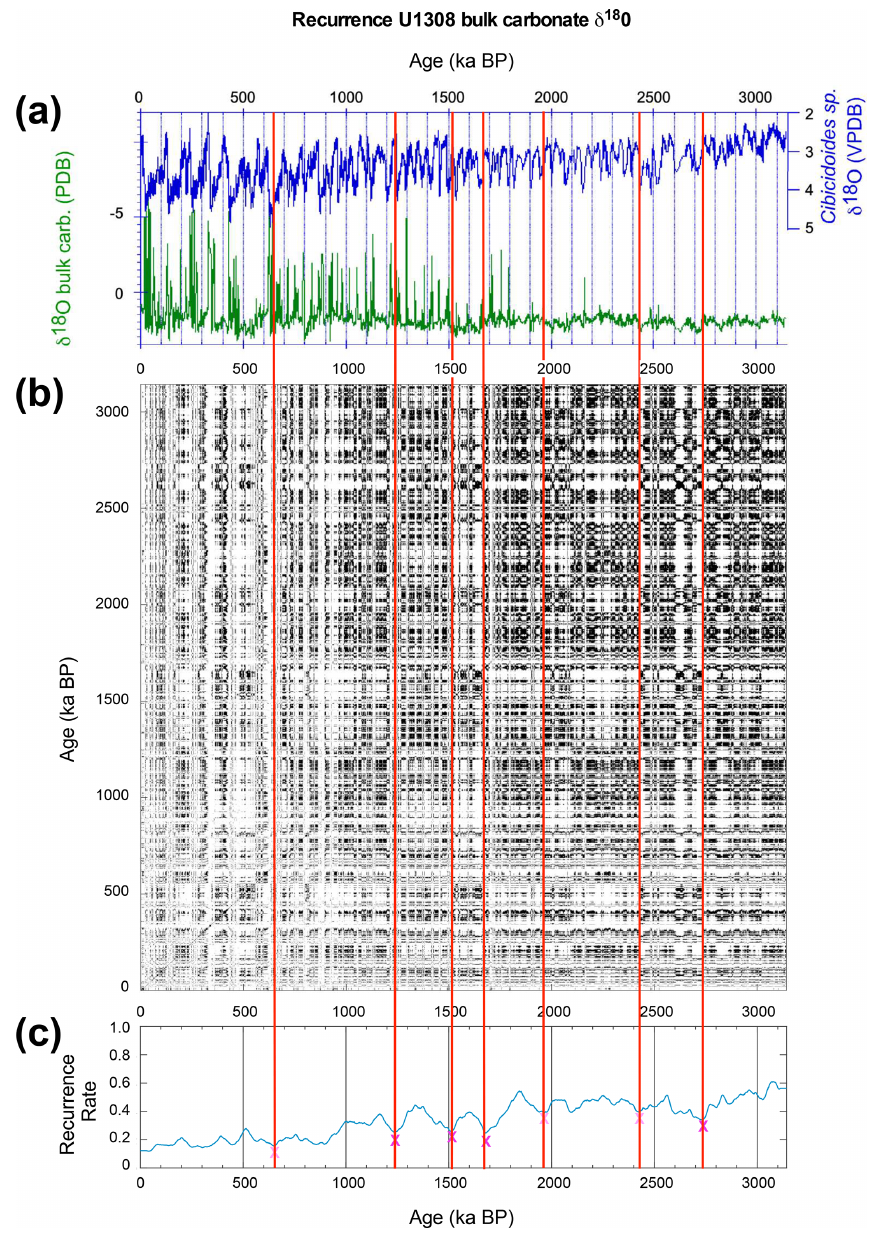
Figure 3. Recurrence analysis of U1308 bulk carbonate δ 18 O (Hodell and Channell, 2016a). Panel (a) is the same as Fig. 2a. (b) RP of the bulk carbonate δ 18 O, with the same proximity threshold as in Fig. 2a. Panel (c) is the same as in Fig. 2c, except that the vertical bars now represent the major thresholds (4 + 3) determined by the RR analysis in panel (c) . The RP website is http://www.recurrence-plot.tk/.